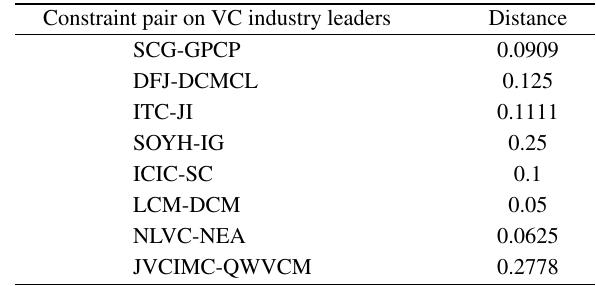
Table 11 Distance between two nodes of each constraint pair of VC industry